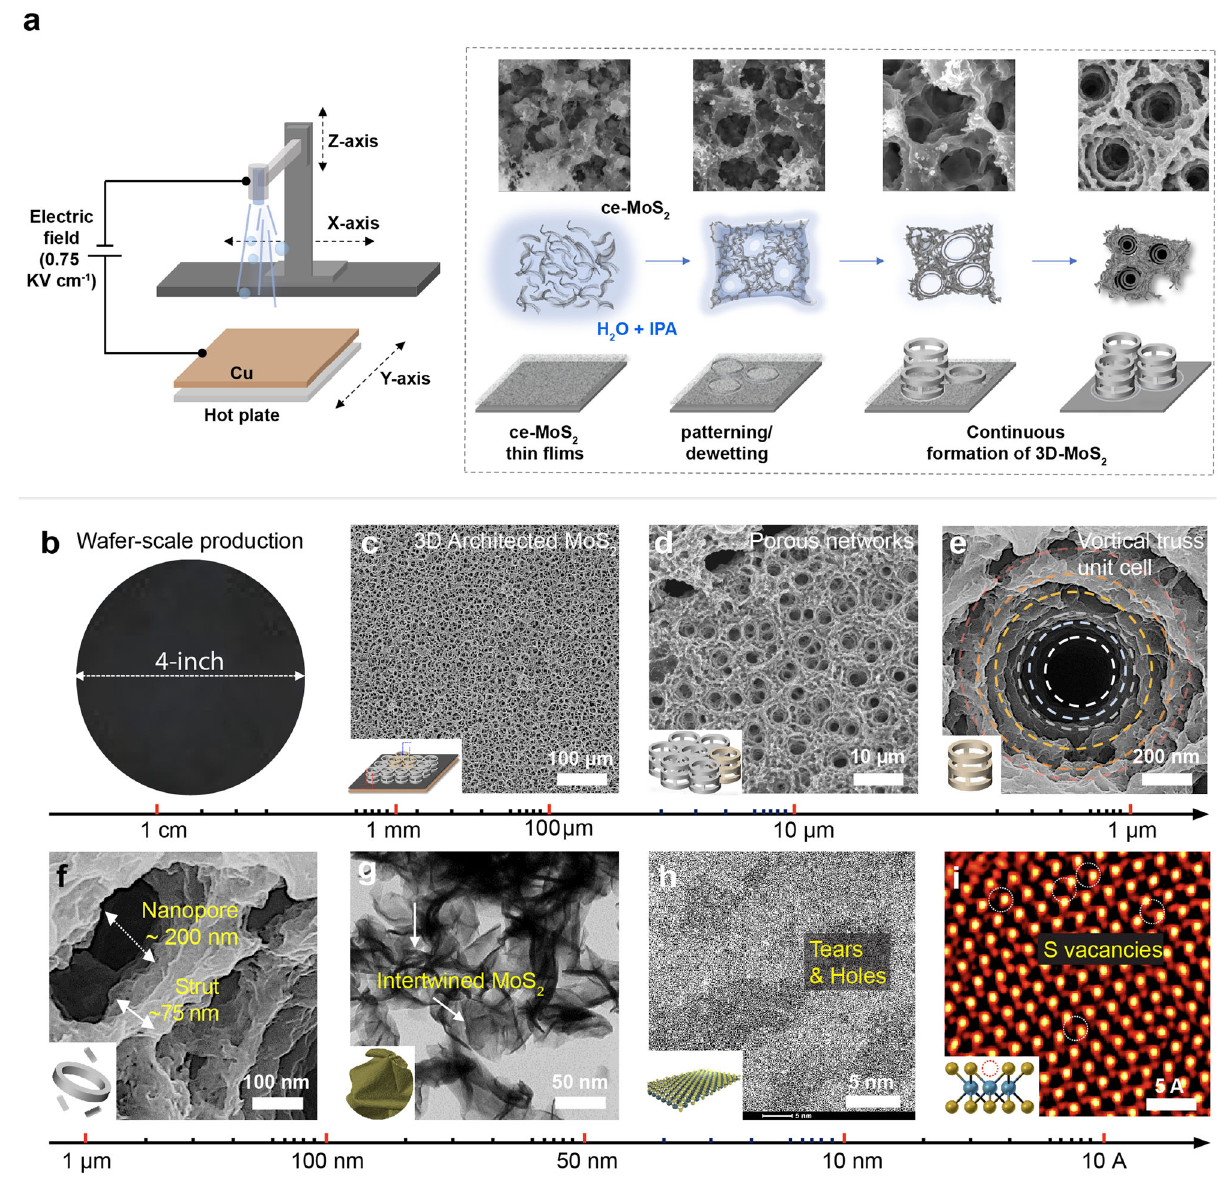
Fig. 1 | Printing 3D MoS 2 foam through dewetting-induced manufacturing. a ThemanufacturingschemeillustratestheEHDsetupandthestructuralevolution oftheMoS 2 foam. b Demonstrationofup-scalablemanufacturingofMoS 2 foamon a 4-inch copper (Cu) substrate that comprises structural hierarchies over seven